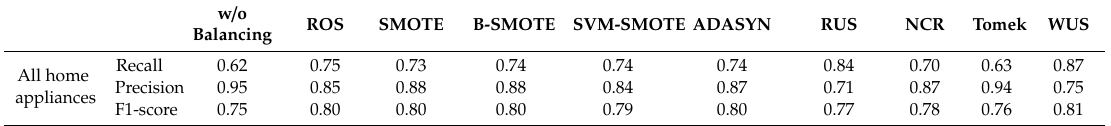
Table 2. Recall, Precision, F1-score results for each sampling method (support vector machine, SVM). Recall, Precision, F1-score results for each sampling method (support Random oversampling—ROS; synthetic minority oversampling technique—SMOTE; borderline- vector machine, SVM). Random oversampling—ROS; synthetic minority SMOTE—B-SMOTE; adaptive synthetic sampling—ADASYN; random undersampling—RUS;